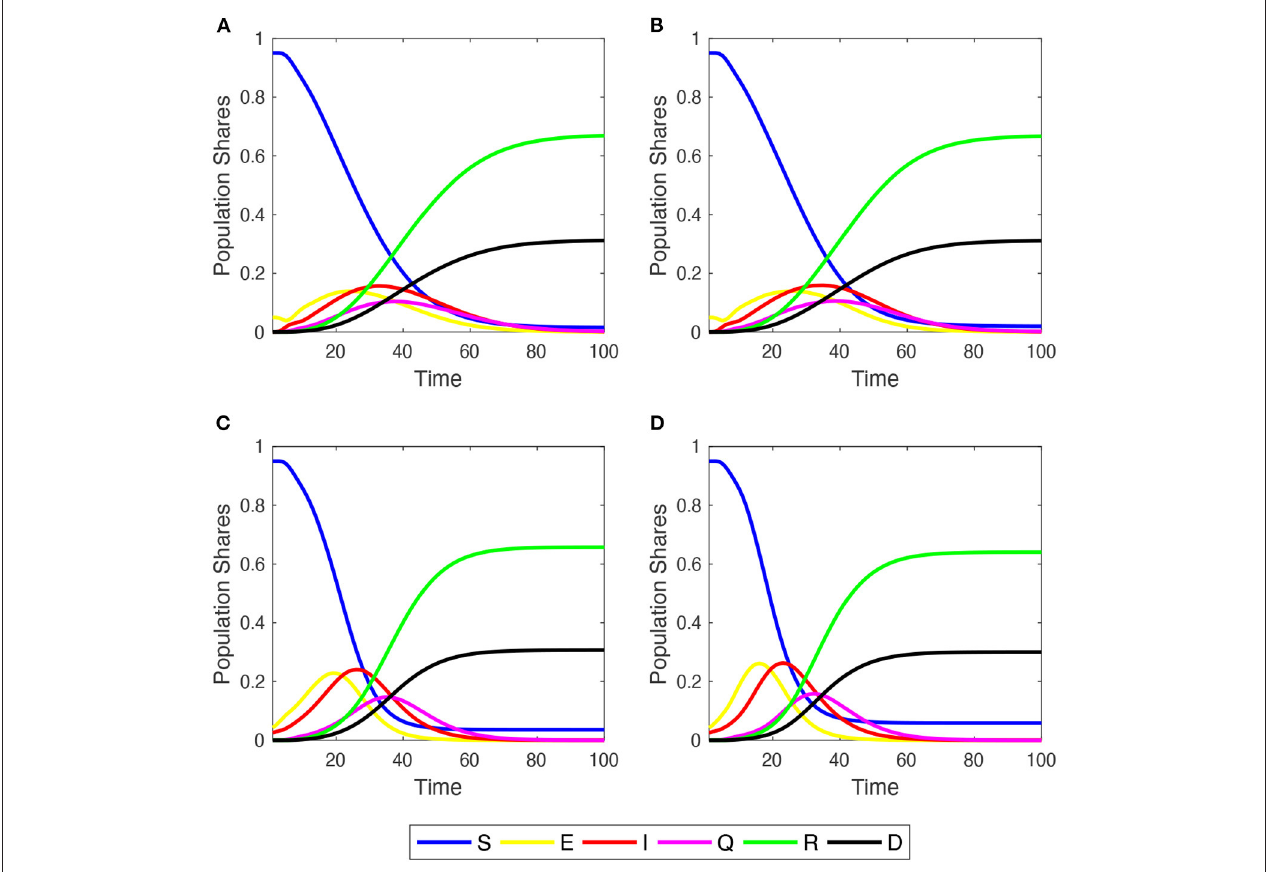
FIGURE 1 | Within-simulation evolution of agent shares in the six compartments over time. Initial ¯ k = 8. Mid-impact epidemic scenario. Averages across M = 1,000 Monte Carlo simulations. (A) Regular 2-dimensional lattice with Moore neighborhoods; (B) small-world lattice; (C) Erdös-Renyi random graph; (D) scale-free network.